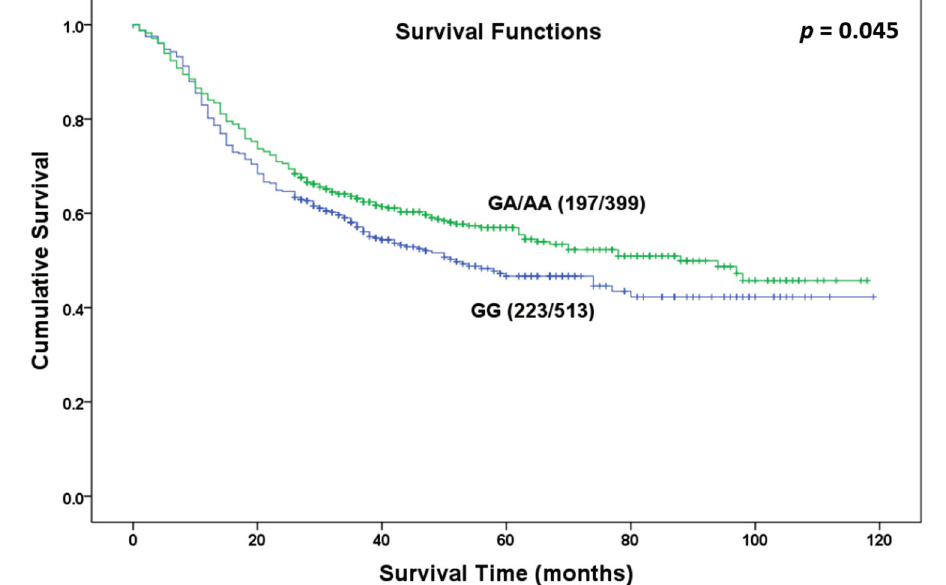
Figure 1. Overall survival curve in relation to NR5A2 rs3790844 polymorphism in patients with gastric cancer in dominant